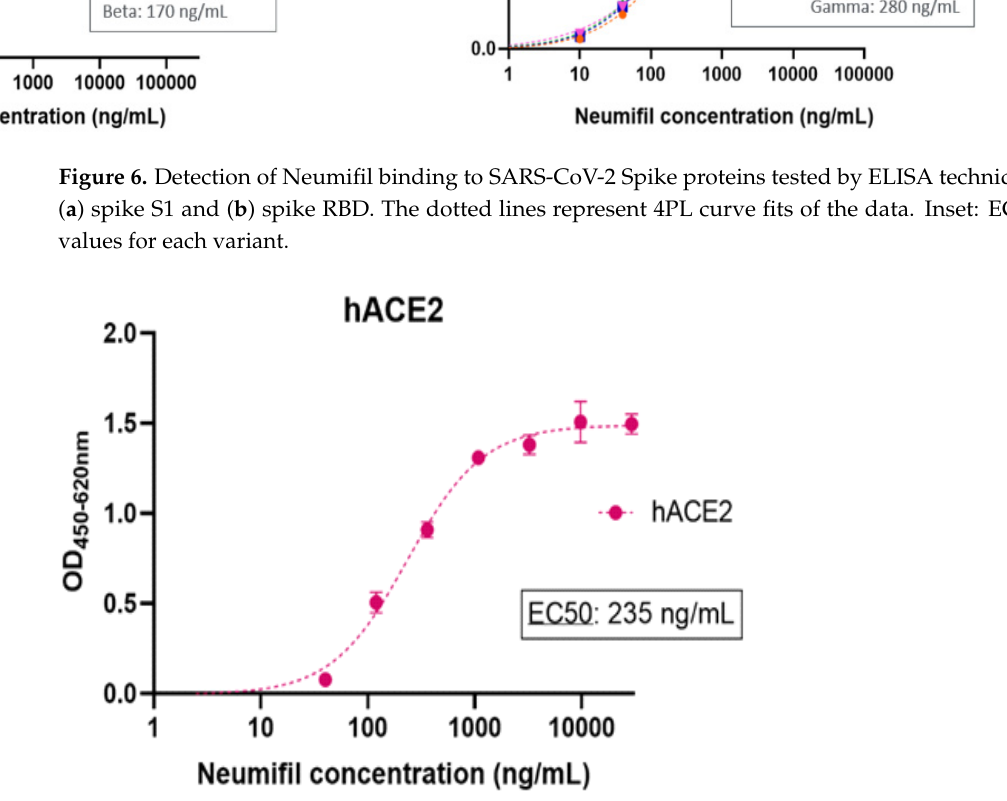
Figure 7. Detection of Neumifil binding to recombinant human ACE2 tested by ELISA technique. The dotted line represents a 4PL curve fitting of the data. Inset: EC50 value.